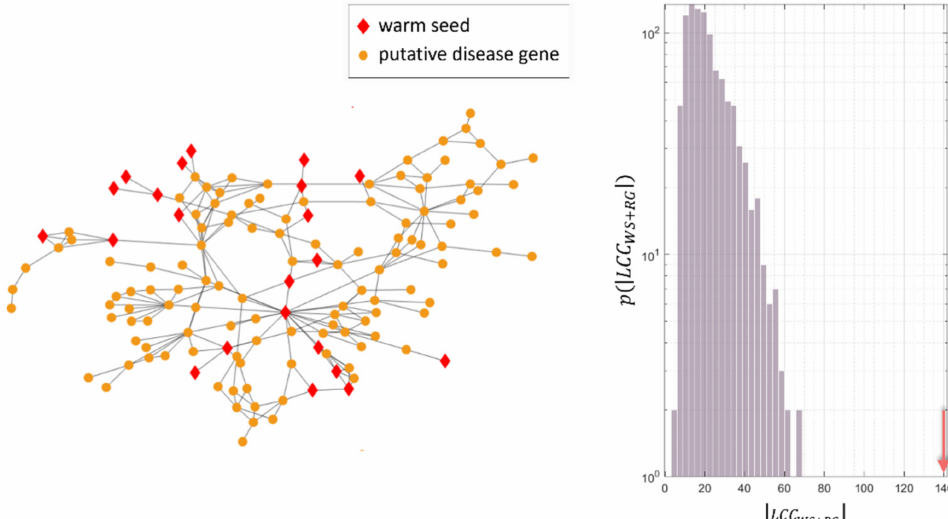
Figure 5. Largest connected component ( LCC ) of the predicted disease module ( warm seeds and putative disease genes) for ulcerative colitis . Node shape codes for the type of genes: red diamonds represent the warm seeds (22 nodes), while orange dots represent the putative disease genes (118 nodes). On the right, distribution of the size of the 1000 LCCs of the random disease modules ( | LCC WS + RG | ) obtained adding to the warm seeds , a set of randomly selected genes with cardinality equal to the set of putative genes; the orange arrow indicates the size of the LCC WS + PG shown in the left